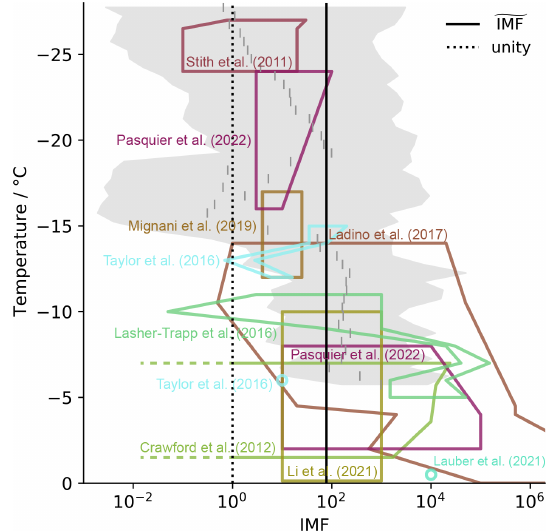
Figure 14. Comparison of obtained ice multiplication factors (IMFs) in this study (gray shading indicating the 10th and 90th per- centiles of observations with the median indicated by vertical lines per temperature bin) to previous field observations. The polygons envelop the observed IMFs per study. Circles indicate observations of one IMF at one temperature. Note that for the study of Craw- ford et al. (2012), no lower limit in IMF could be determined. Note that the retrieved IMFs from Ladino et al. (2017) tend towards 10 9 for temperatures towards 0 ◦ C. The dashed black line and the solid black line indicate an IMF of unity and the observed median IMF in this study,